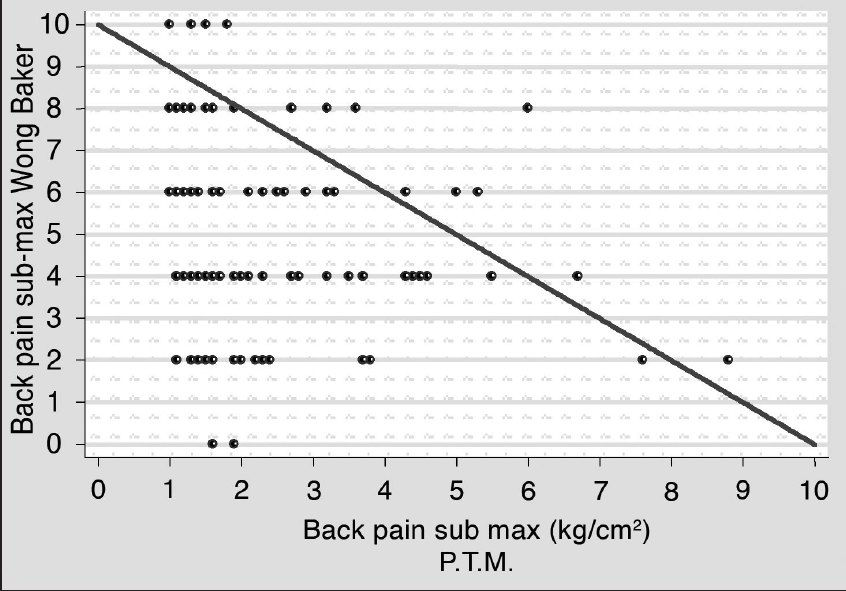
Figure 8: Scatter plot of the maximum pressure pain vs the patient perception on the Wong-Baker Faces pain